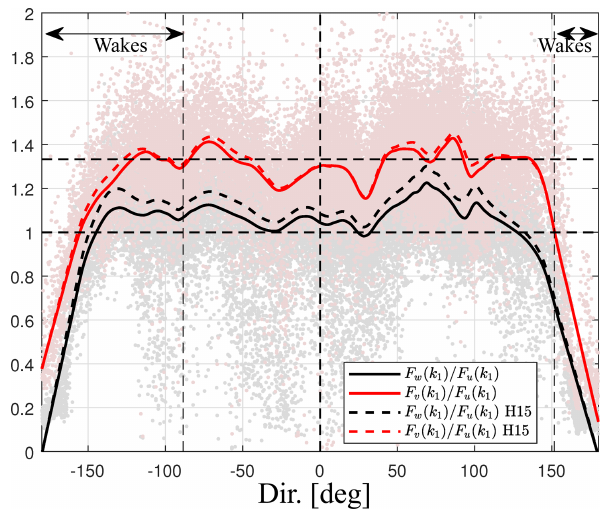
Figure 9. CSAT3 velocity spectra ratios with wind direction at the Nørrekær Enge wind farm. Horizontal and vertical dashed lines as in Fig. 4. The standard error of the fit to the w to u velocity spectra ratios is within 0.0038–0.0086 for the H15